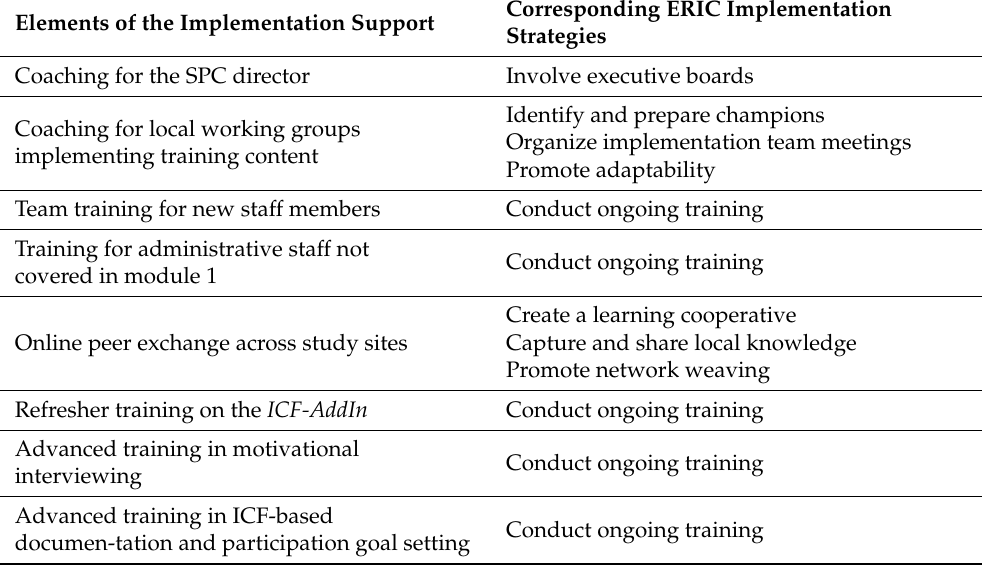
Table 1. Elements of the implementation support and corresponding ERIC implementation strategies (module